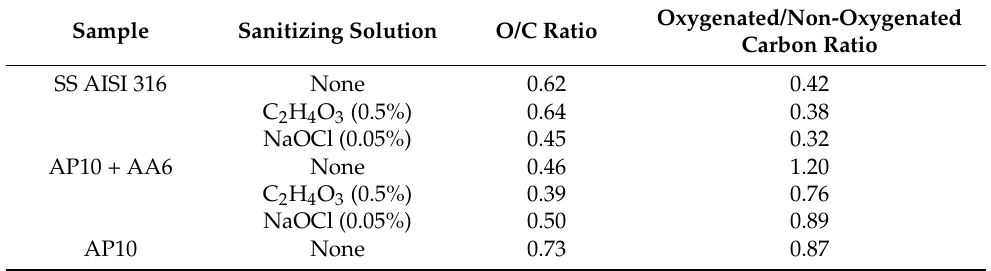
Table 3. O/C ratio and oxygenated/non-oxygenated carbon ratio of the studied